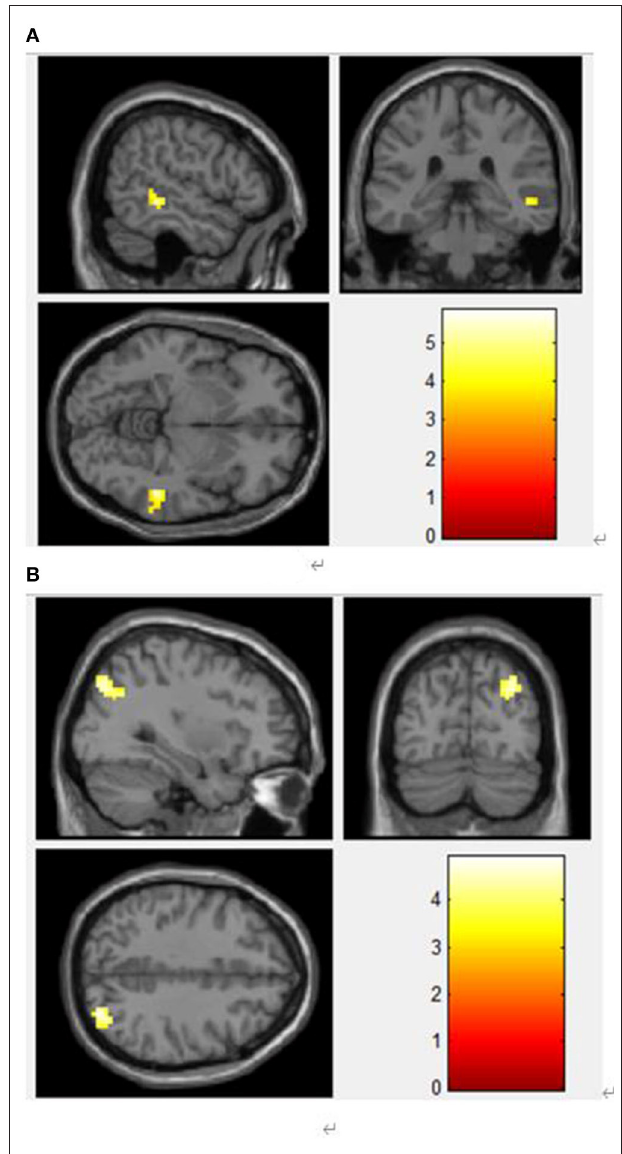
FIGURE 4 | (A) Functional connection enhancement area of DCG and MTG. (B) Functional connection enhancement area of the left OG and the right middle occipital